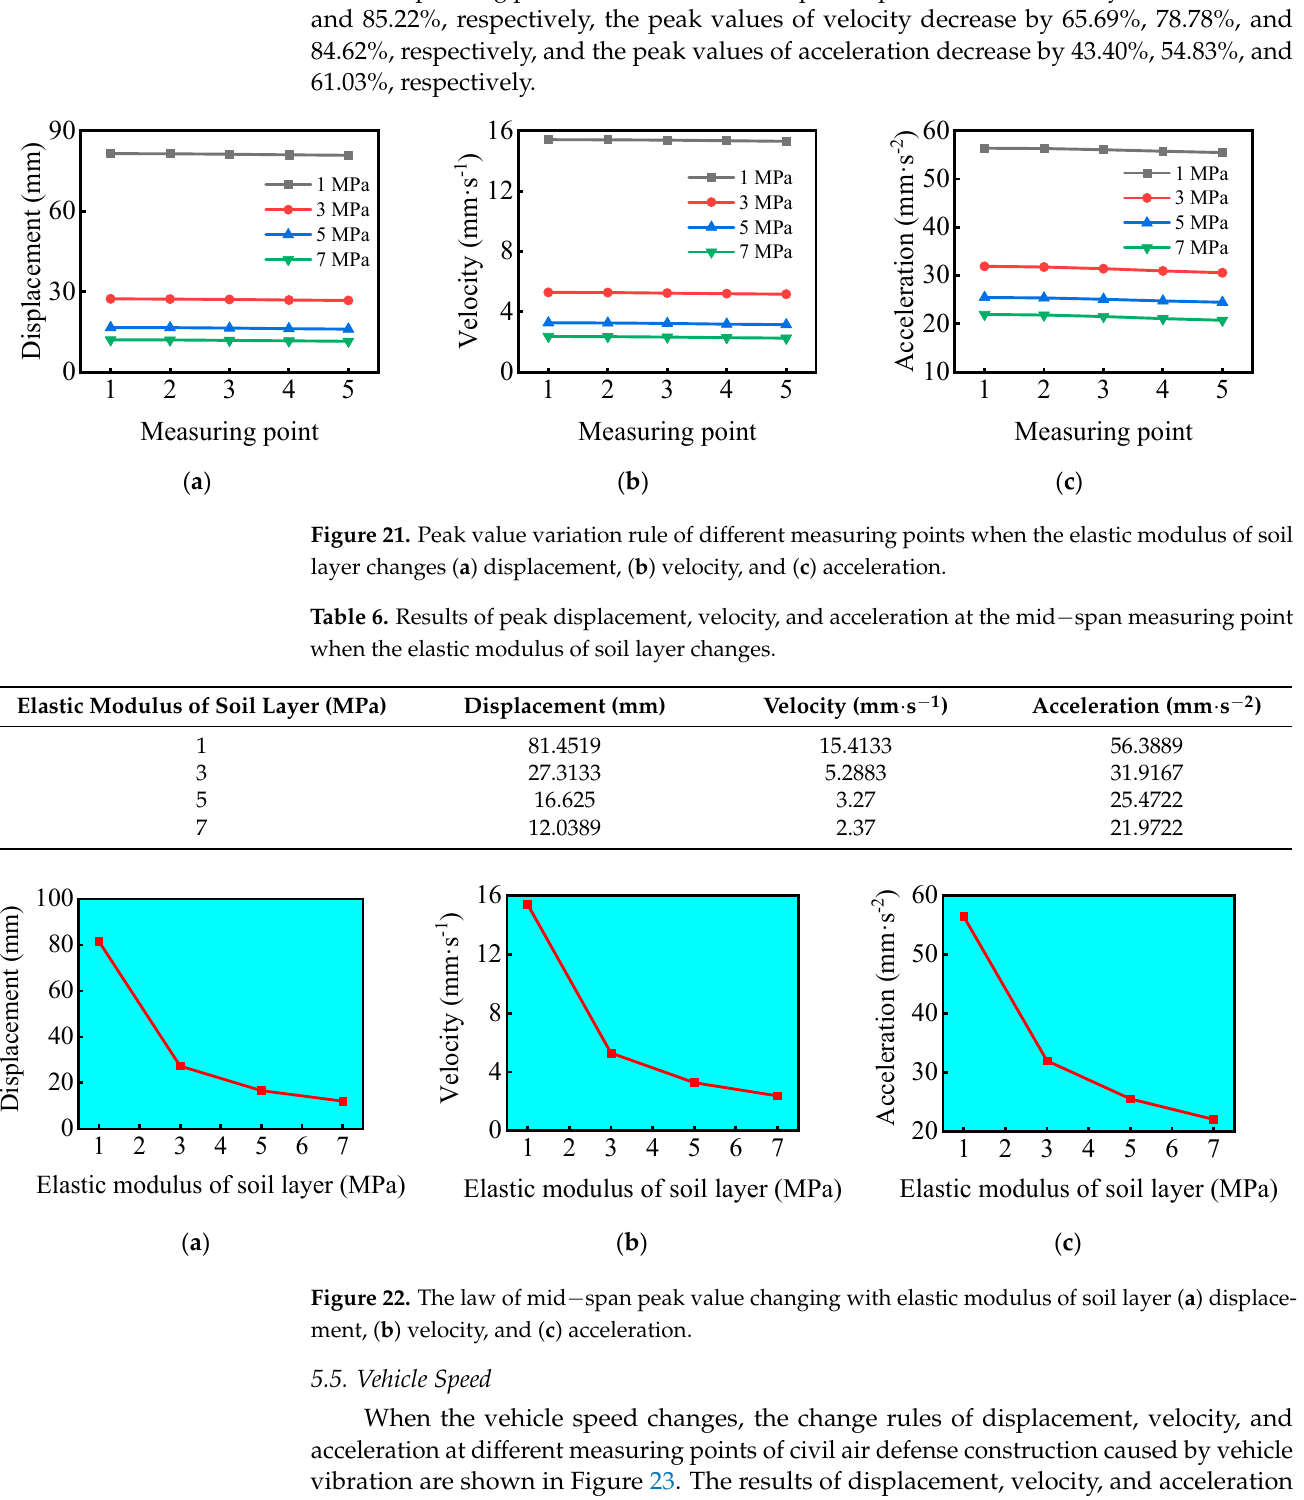
Table 6. Results of peak displacement, velocity, and acceleration at the mid − span measuring point when the elastic modulus of soil layer changes.